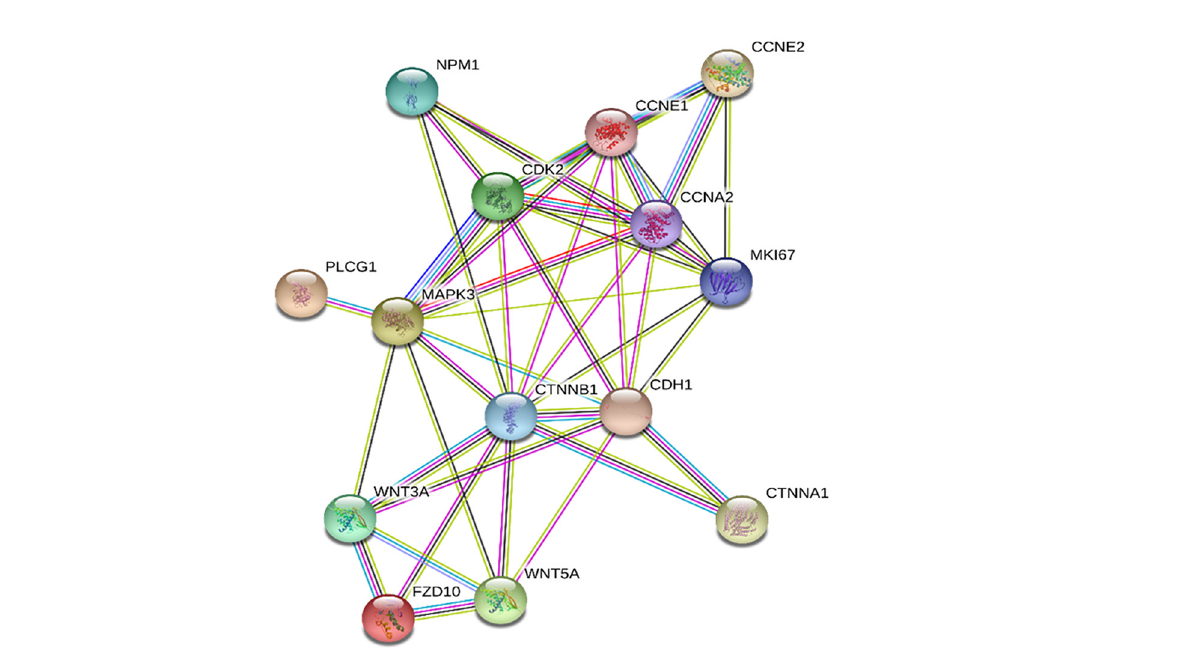
FIGURE 3 | Frizzled (FZD)10 and Ki-67 protein interaction network by Search Tool for the Retrieval of Interacting Genes/Proteins (STRING). The network nodes are proteins; the edges represent the predicted functional associations based on seven different types of evidence including fusion evidence, neighborhood evidence, co-occurrence evidence, experimental evidence, text mining evidence, database evidence, and co-expression evidence. Color legend: □ curated databases; □ experimentally determined; □ co-expression; □ gene neighborhood; □ gene fusions; □ gene co-occurrence; □ text mining; □ protein